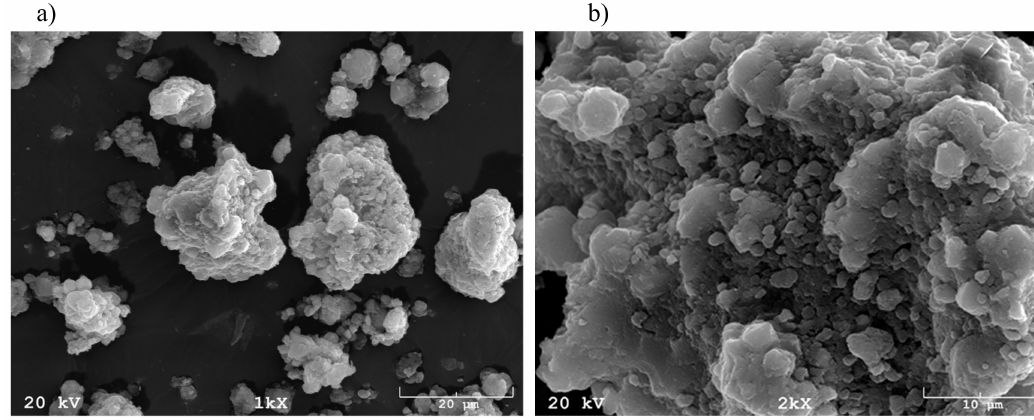
Figure 3. A SEM microscope image for a sample of the tu ff of Filipowice created in a process of synthesis by fusion method and modified with Ca(OH) 2 (CaTF); ( a ) zoom 1000 × ; ( b ) zoom 2000 × .